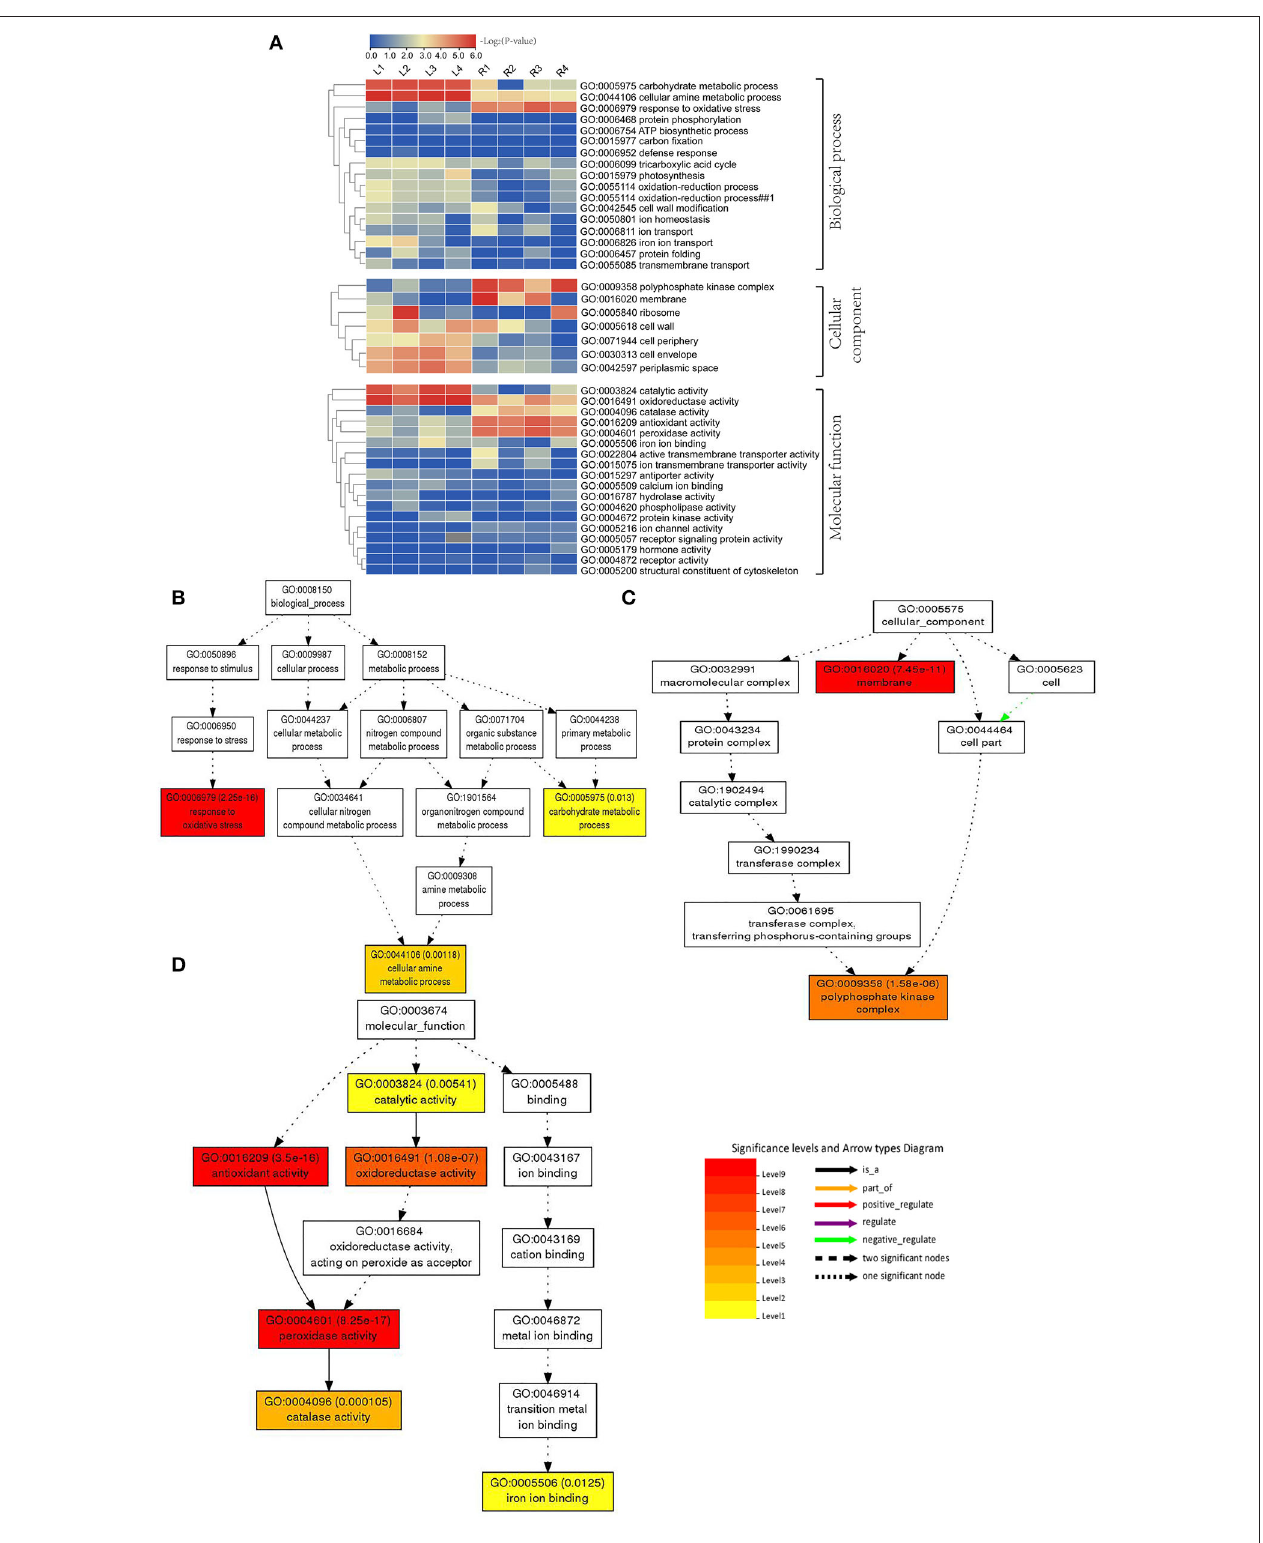
FIGURE 4 | GO enrichment results of DEGs after NaCl treatment. (A) GO annotation results of DEGs; (B – D) GO term for DEGs that respond to salt stress. Each box represents a GO term; the depth of the color represents the degree of enrichment, and the darker the color, the higher the degree of enrichment.